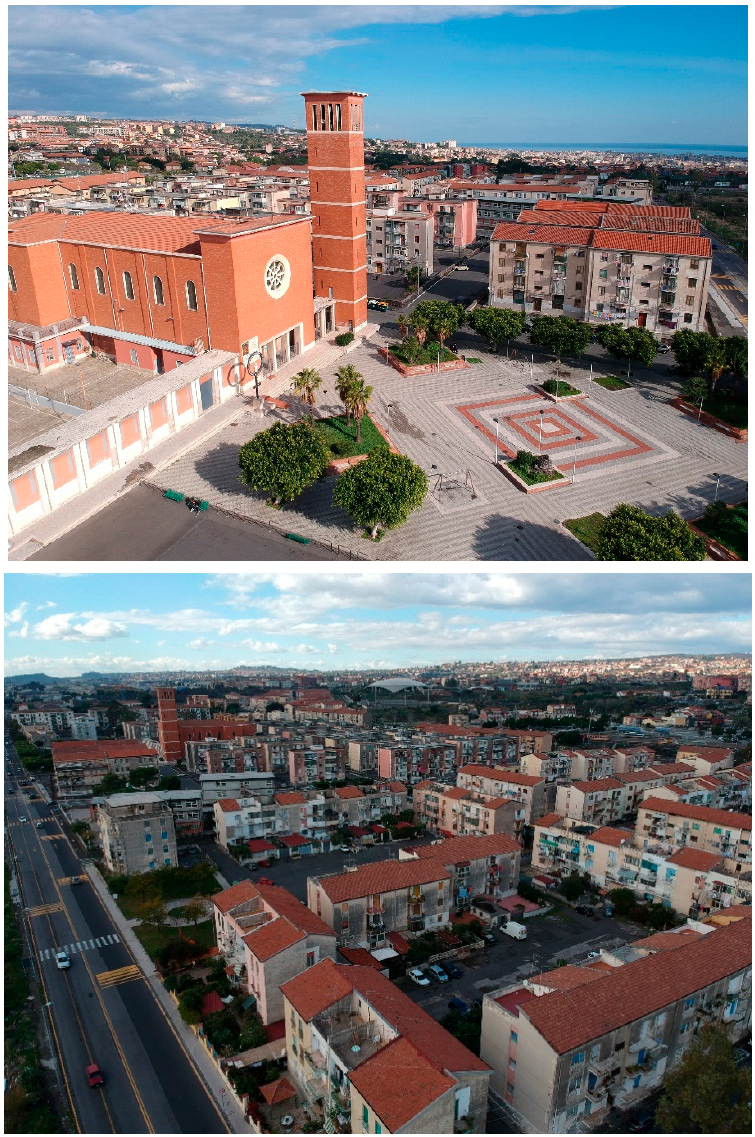
Figure 3. Panoramic views of the urban area selected as case study.